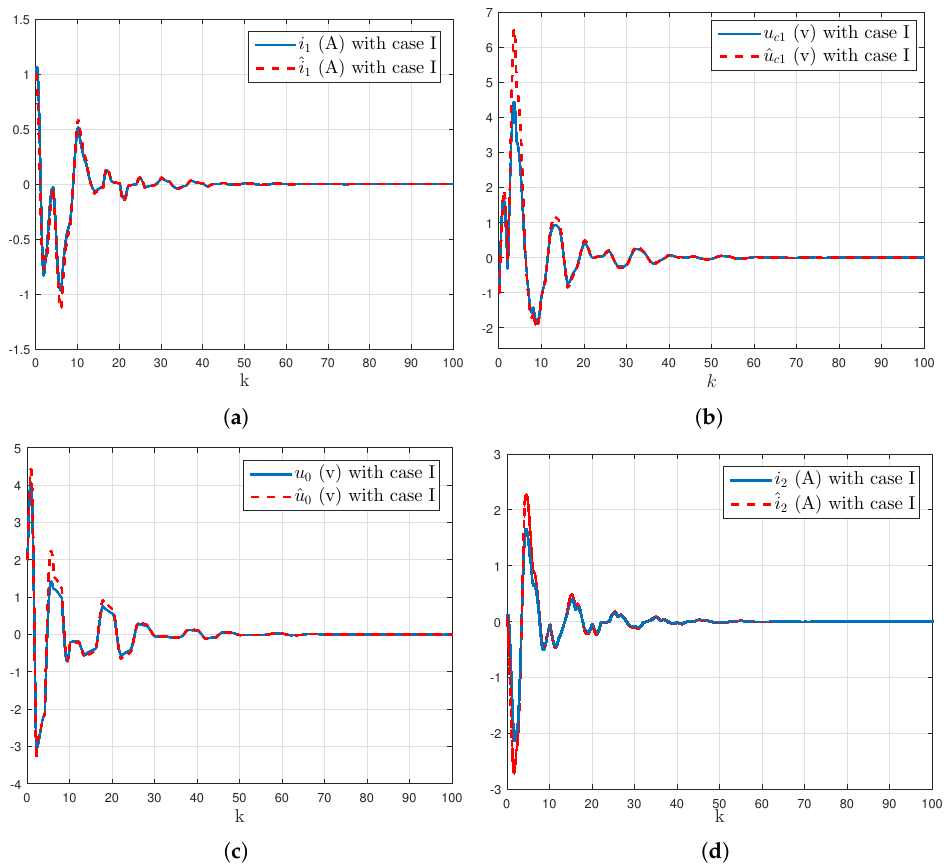
Figure 8. Simulation results for example 2. ( a ) Response and estimate trajectories of i 1 . ( b ) Response and estimated trajectories of u c 1 . ( c ) Response and estimated trajectories of u 0 . ( d ) Response and estimate trajectories of i 2